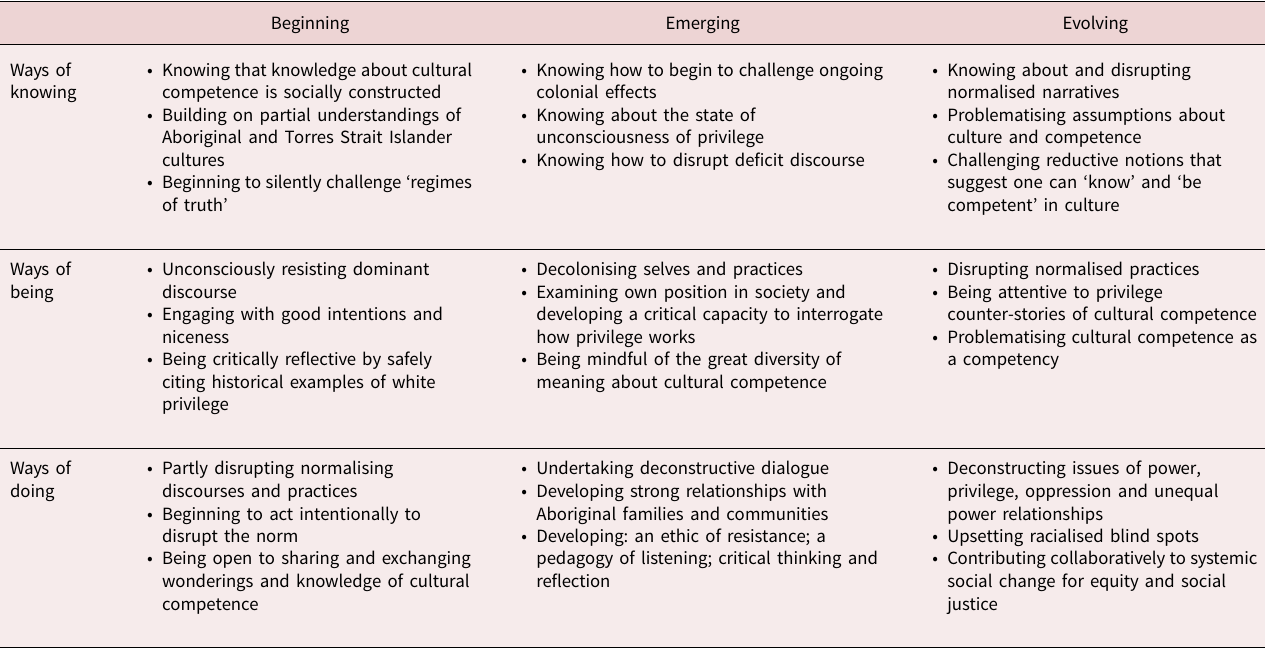
Table 1. Framework of positioning self in relationship to ways of knowing, being and doing ‘ cultural competence ’